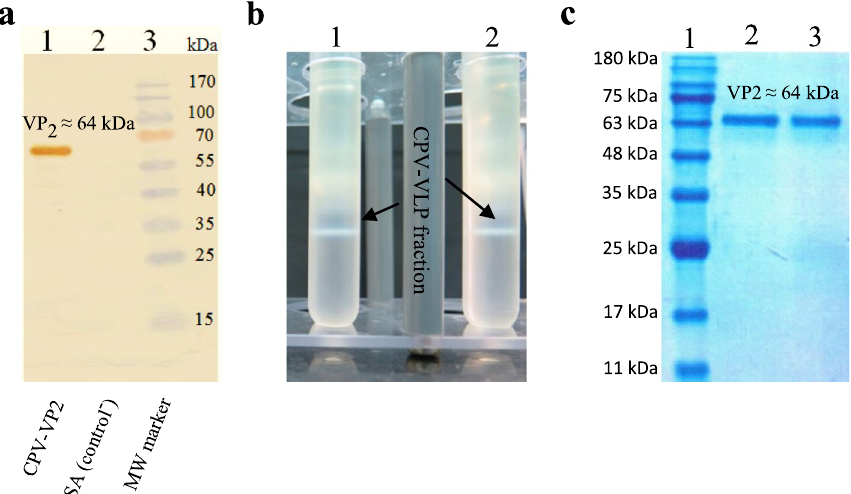
Fig. 5 a The result of western blotting for recombinant expressed VP2, Lane 1: The VP2 band (~64 kDa) confirmed by using a specific mouse monoclonal antibody against this protein, Lane 2: The negative control (BSA), Lane 3: Prestained protein ladder (MyBioSource, USA). b The protein fraction resulting from the accumulation of intended VLP nanoparticles in tubes 1 and 2 containing discontinuous cesium chloride gradient